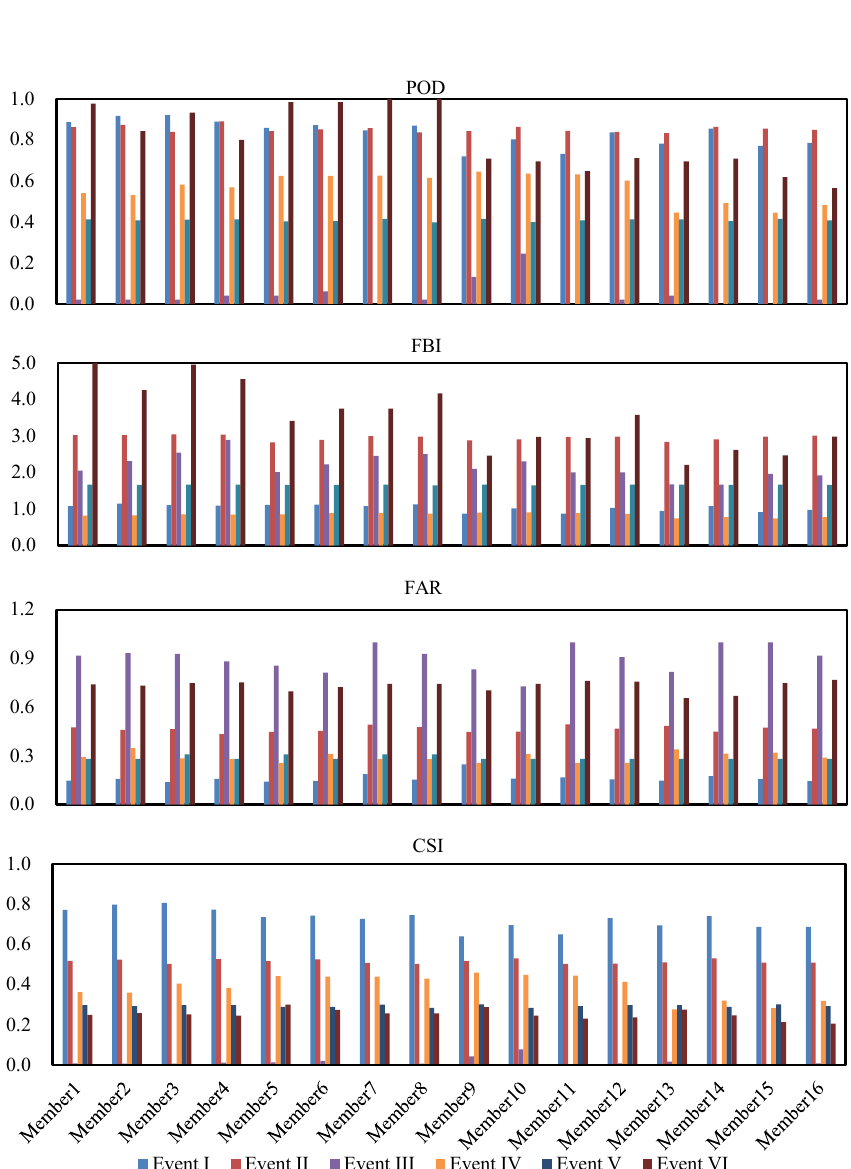
Figure 7. Temporal values of the four categorical indices for different storm events with the 16 members of the physical